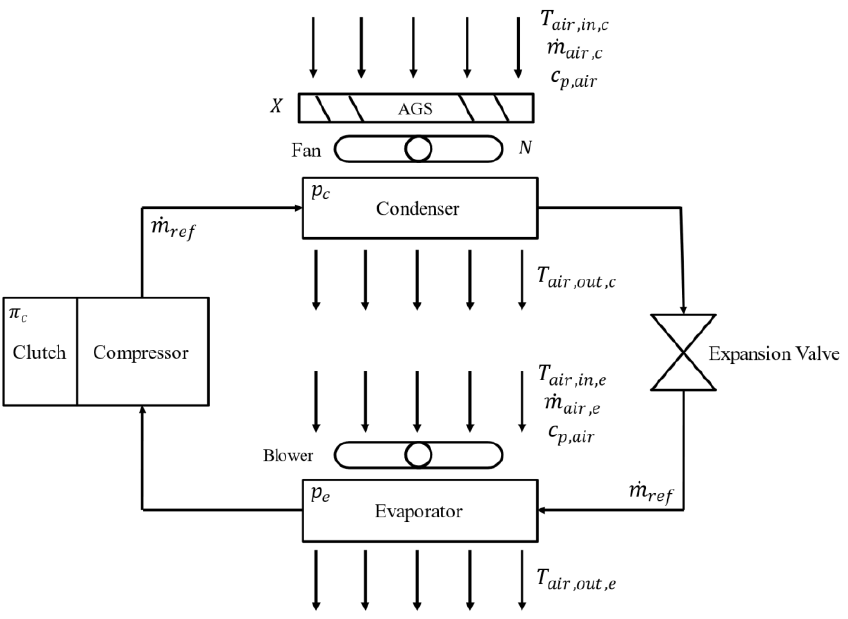
Figure 1. A/C system diagram.